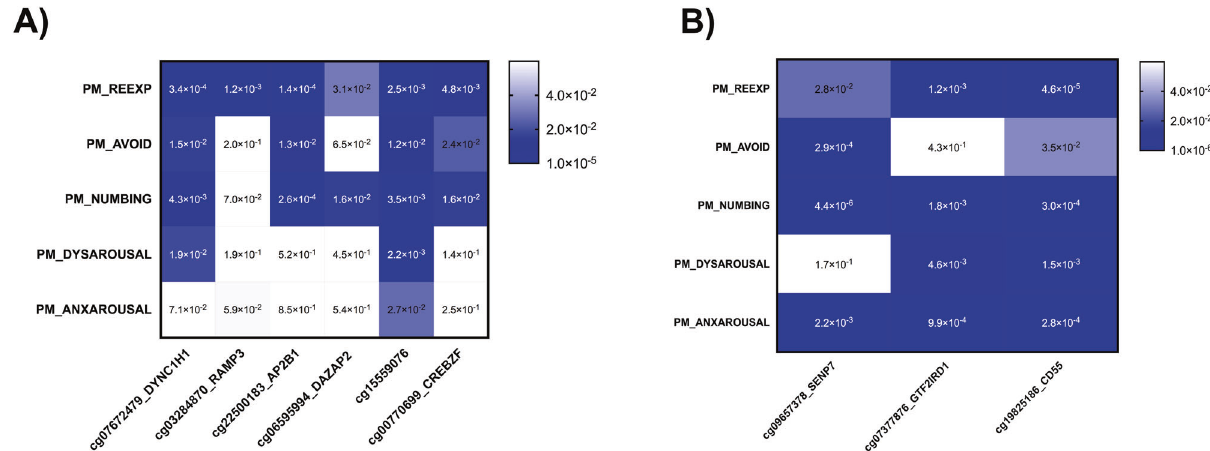
Fig. 2 Heatmap of P -values signi fi cance for genome-wide signi fi cant (GWS) CpG sites and PTSD symptomatology. A Current PTSD, B Lifetime PTSD. Heatmap colors correspond to the signi fi cance ( p -value), where darker indicates higher degree of association, lighter indicates a lower degree of association, and white indicates no